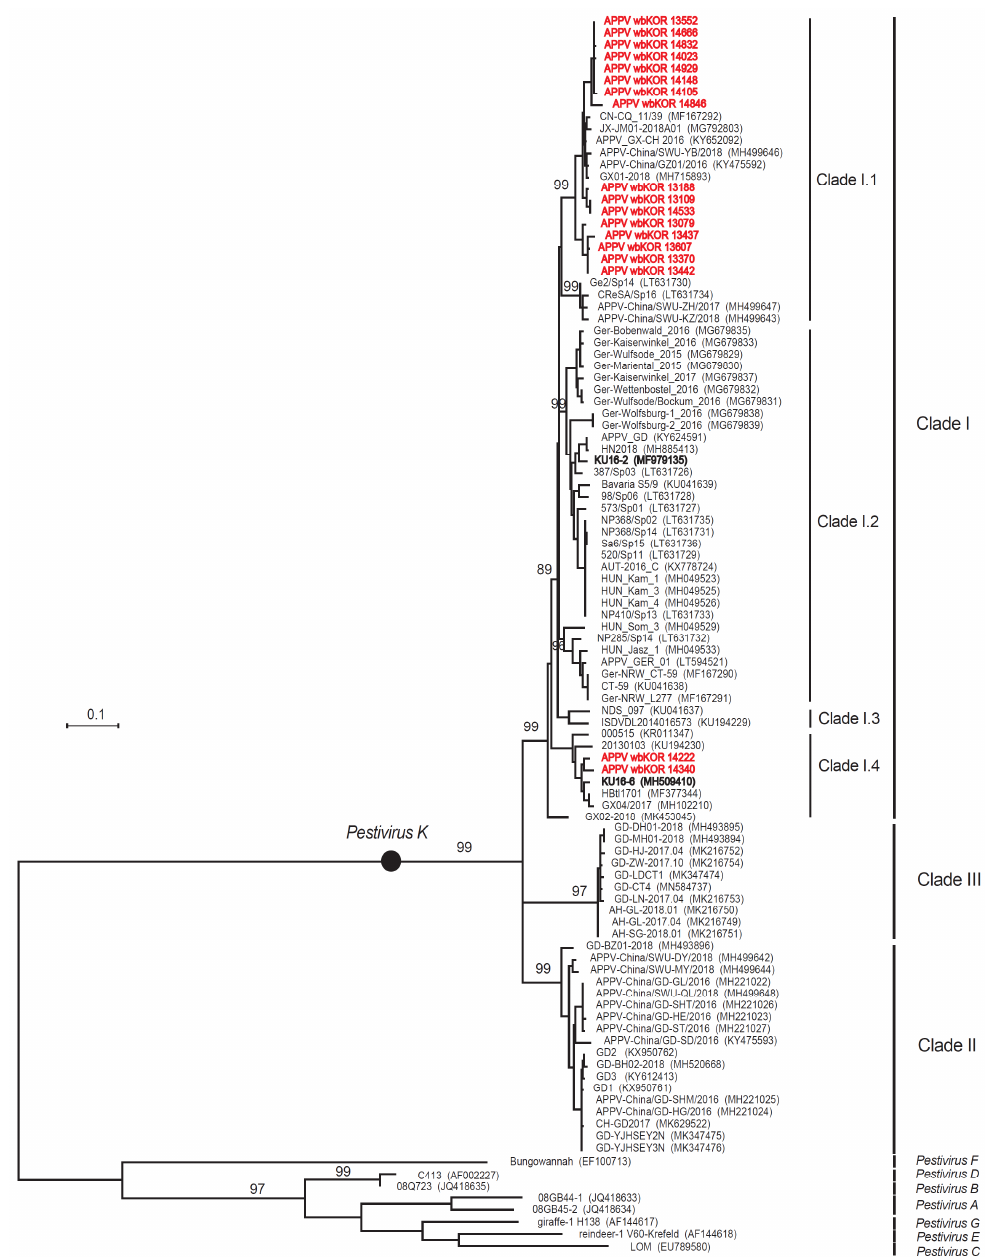
Figure 2. PhylogenetictreeofSouthKoreanwildboarAPPVs, basedonNS3sequences. Thephylogenetic tree was constructed using the ML method (based on the Tamura–Nei model), with bootstrap